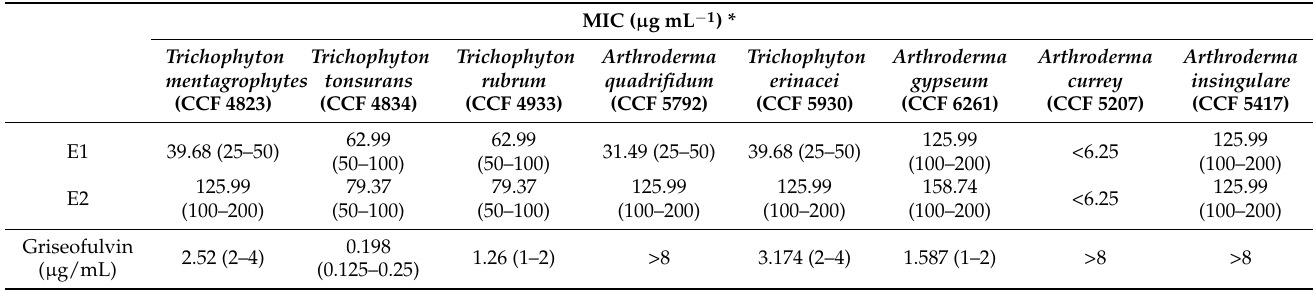
Table 5. Minimal inhibitory concentrations of Cannabis sativa L. cv. strawberry extracts against dermatophyte strains.